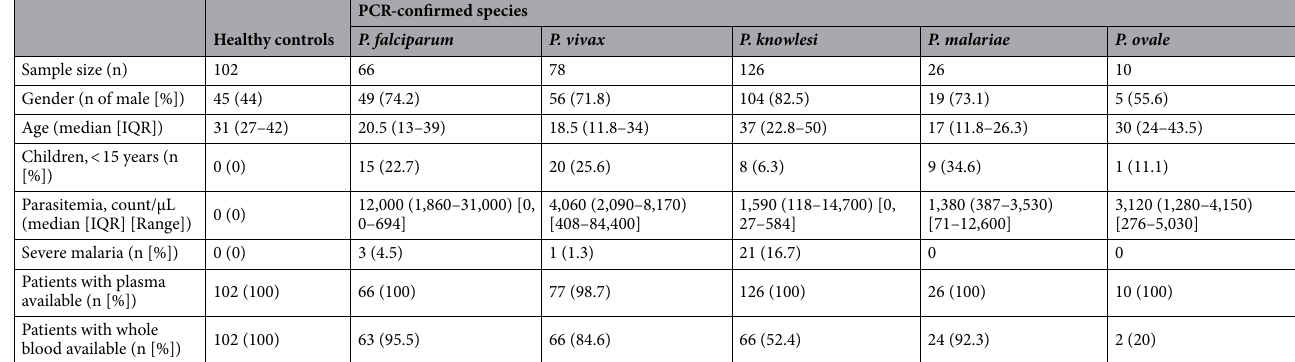
Table 1. Baseline characteristics. Demographic data missing for 1 P. ovale patient; parasitemia missing for 1 P. knowlesi patient. PCR polymerase chain reaction, IQR